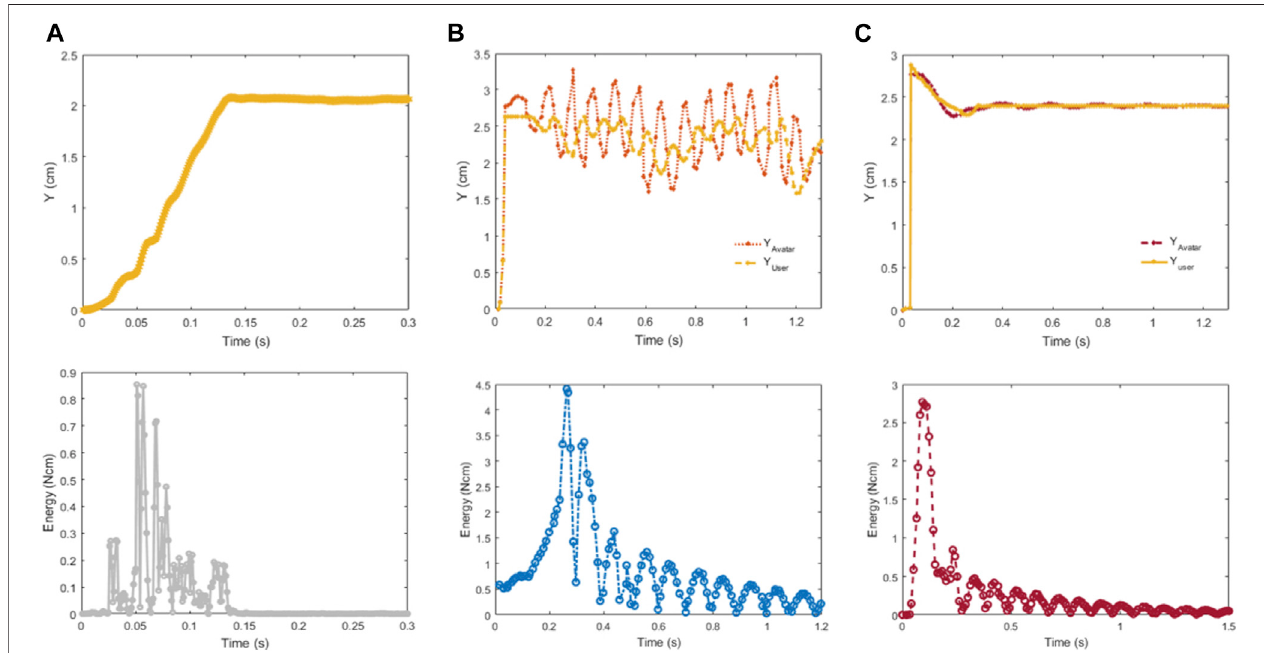
FIGURE 8 | Abrupt movements of varying loads. The position, i.e. , X avatar as it tracks X user (upper) and kinetic energy (lower) of the load for (A) the original avatar 25 Gram; (B) for the avatar with 20 times more mass than the original avatar without the passivity controller, and (C) with the passivity controller.